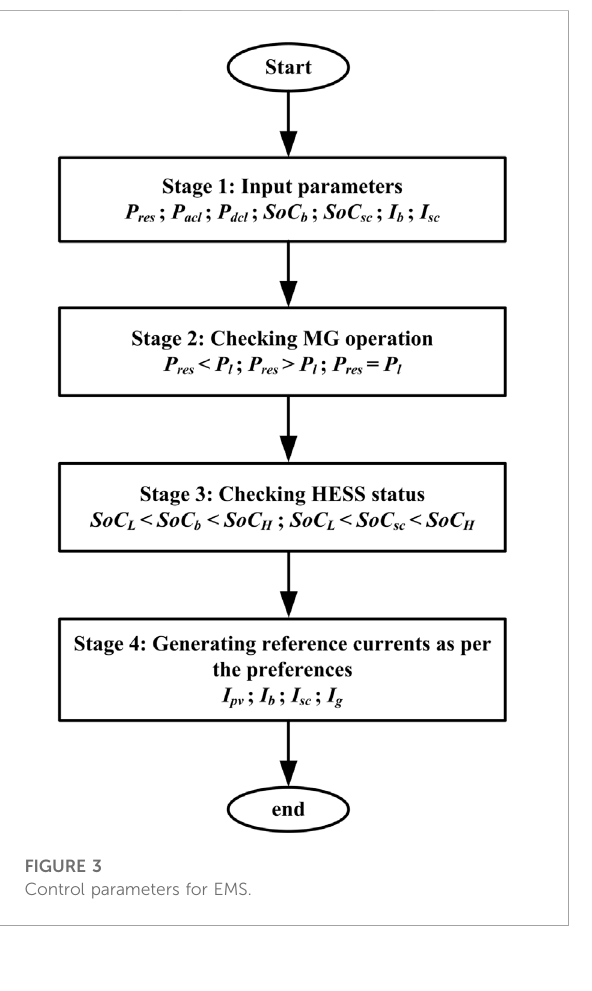
linked to the utility grid using a common DC-link. The BS and SC are connected to a common DC-link with two bidirectional buck- boost converters. During excess (EPM) or de fi cit mode (DPM),